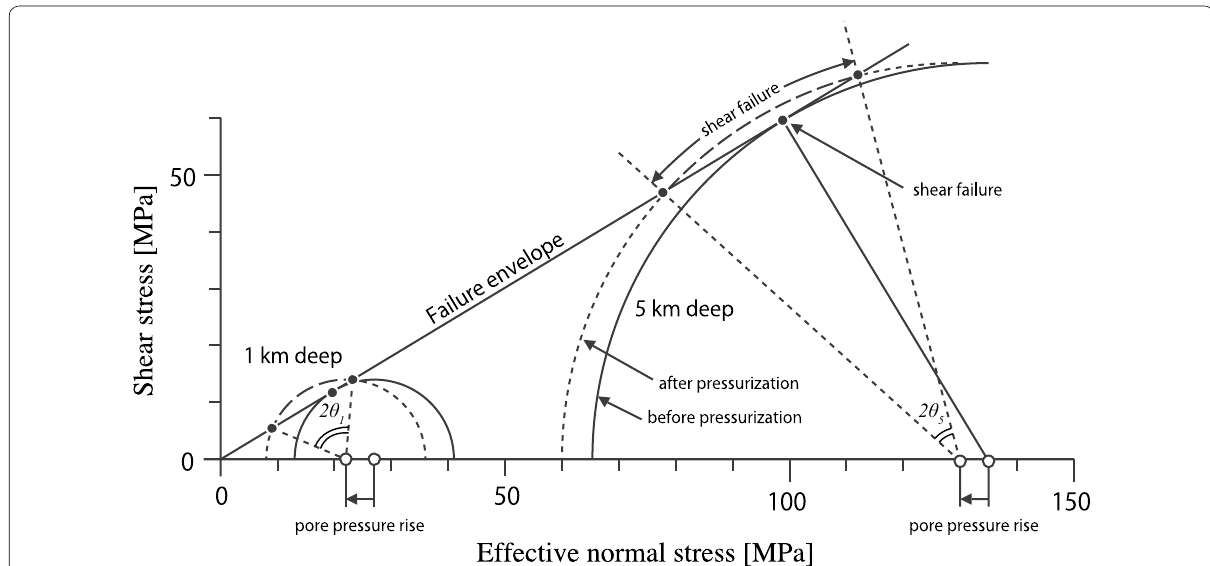
Fig. 20 A conceptual model to explain deepening of seismicity due to pore pressure rise on a Mohr’s diagram. A strike slip stress field in which intermediate principal stress is vertical is assumed here. Before a pore pressurization, optimally oriented faults are assumed to be close to shear failure condition regardless of depth since earthquake swarms are ongoing beneath the volcano (< 6 km in depth). After a pore pressure rise, faults are more randomly oriented and are activated to failure throughout the system and a seismic surge commences. However, the orientation range of activated faults is larger in shallower ( θ 1 > θ 5 ) regions. Thus, the seismicity is more active where shallower and activation in deeper regions needs further pore pressure